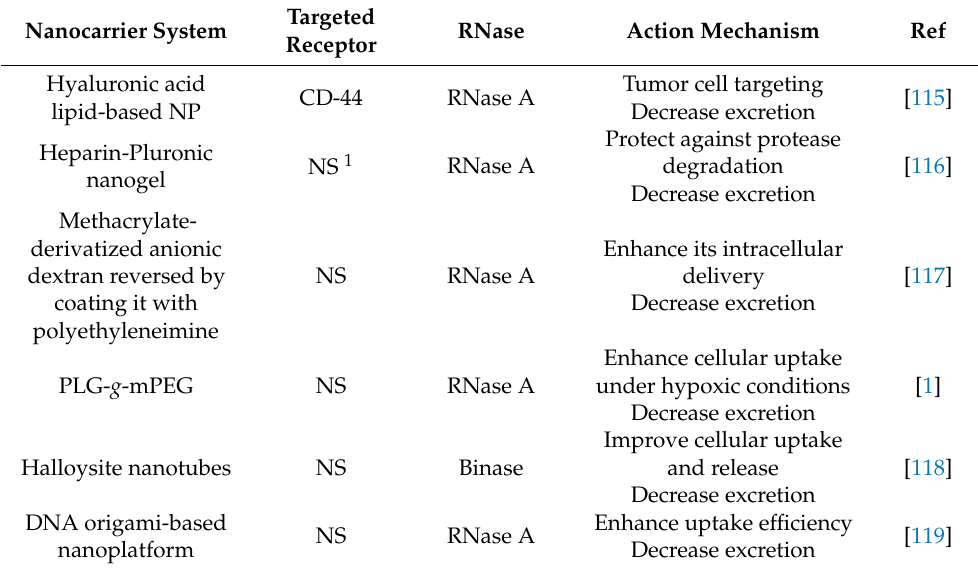
Table 1. Examples of nanocarrier systems used to improve the pharmacokinetic properties of antitumor